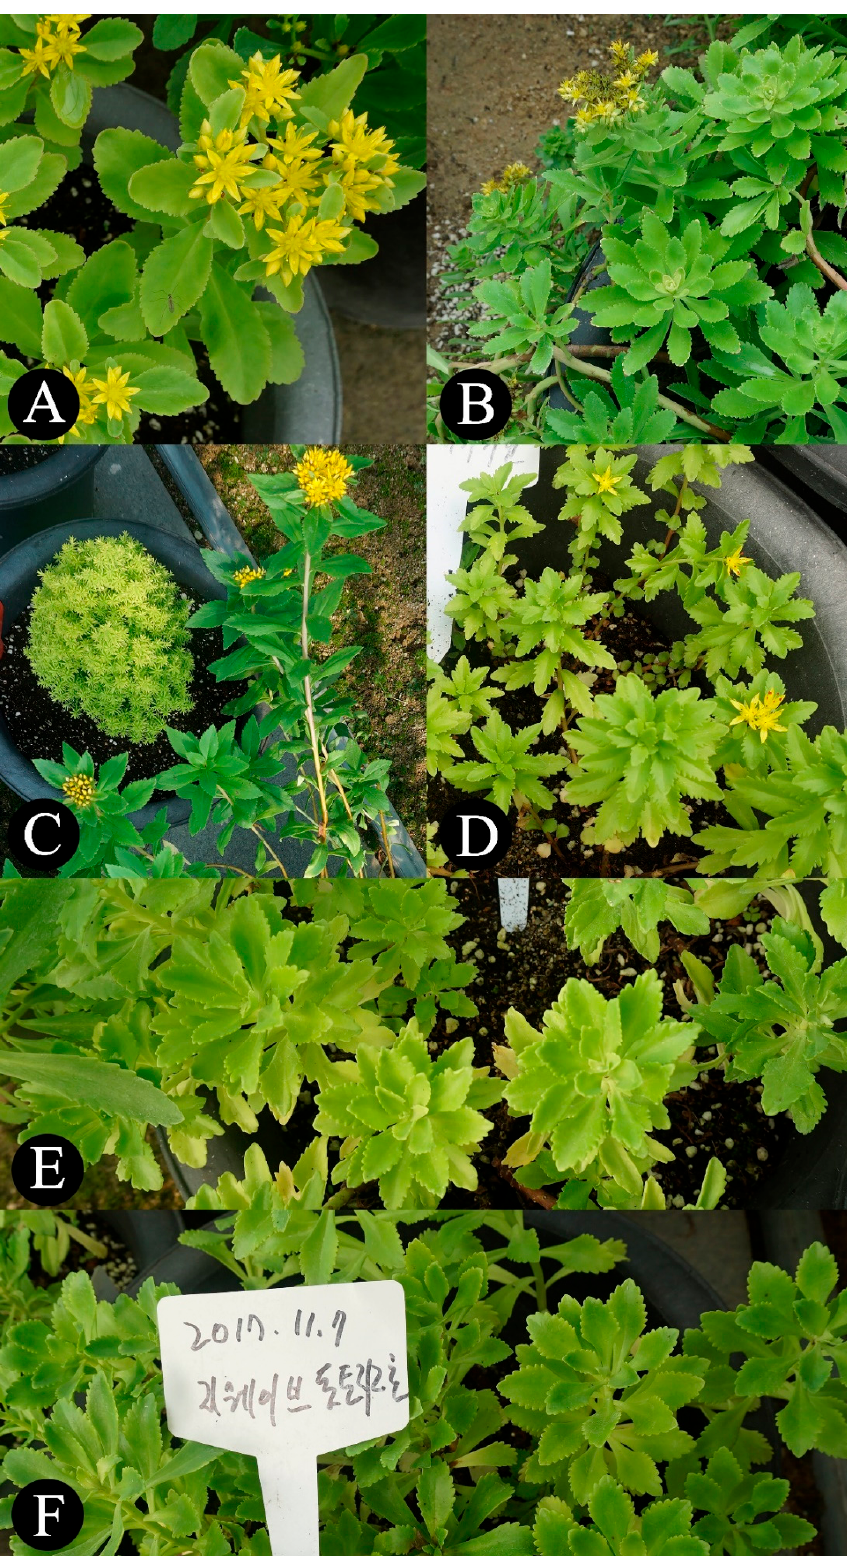
Figure 1. Plant materials of the genus Phedimus used for analysis. ( A ) Phedimus kamtschaticus , ( B ) Phedimus takesimensis , ( C ) Phedimus aizoon , ( D ) Phedimus middendorffianus , ( E ) “Tottori Fujita 1gou”, and ( F ) “Tottori Fujita 2gou”.